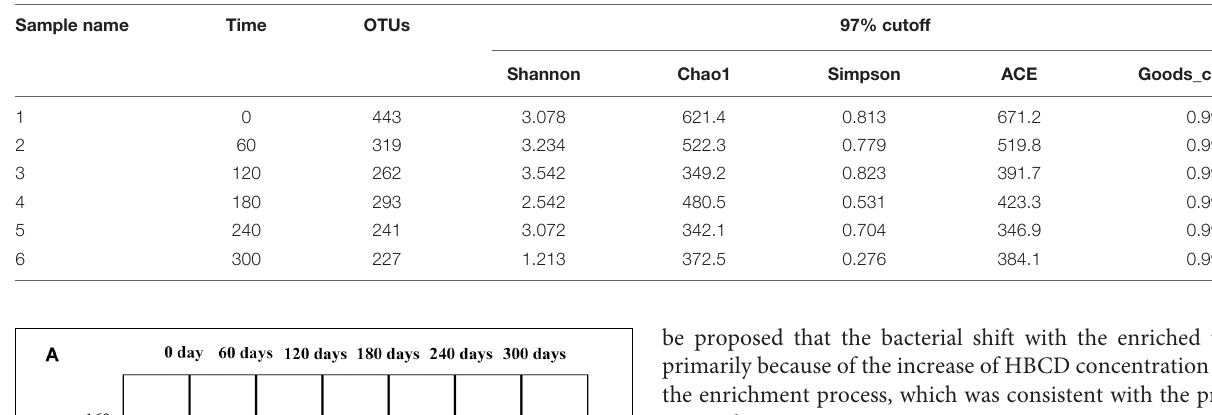
TABLE 2 | The α diversity of each sample.